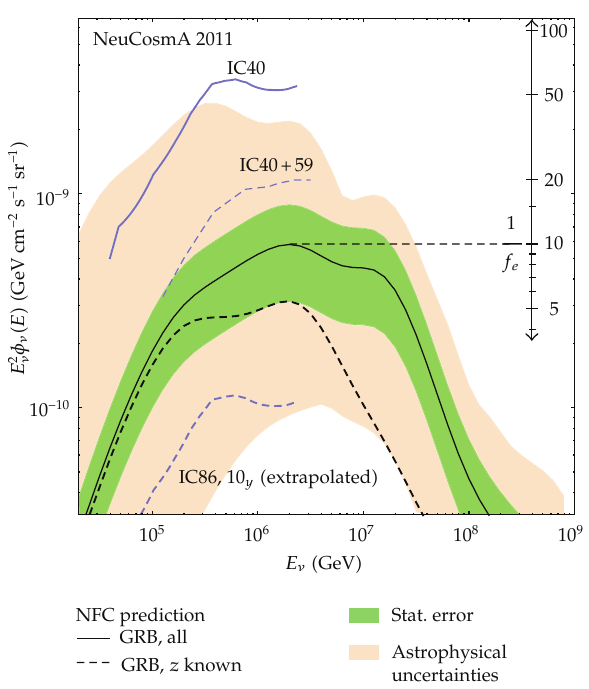
Figure 14: Numerical prediction (cid:3) NFC (cid:4) of the quasi-di ff use flux expected from the bursts used in the IC40- analysis, including the estimates for several model- or method-specific systematical uncertainties (cid:3) see main text (cid:4) . In addition, the IC40 limit is shown, and two expectations are shown for comparison (cid:3) IC59 (cid:8) 40 from (cid:9) 3 × A IC40 (cid:5) 19 (cid:6) and IC86 extrapolated for A IC86 from IC40; see, e.g., (cid:5) 87 (cid:6)(cid:4) , figure taken from (cid:5) 44 (cid:6) e ff e ff